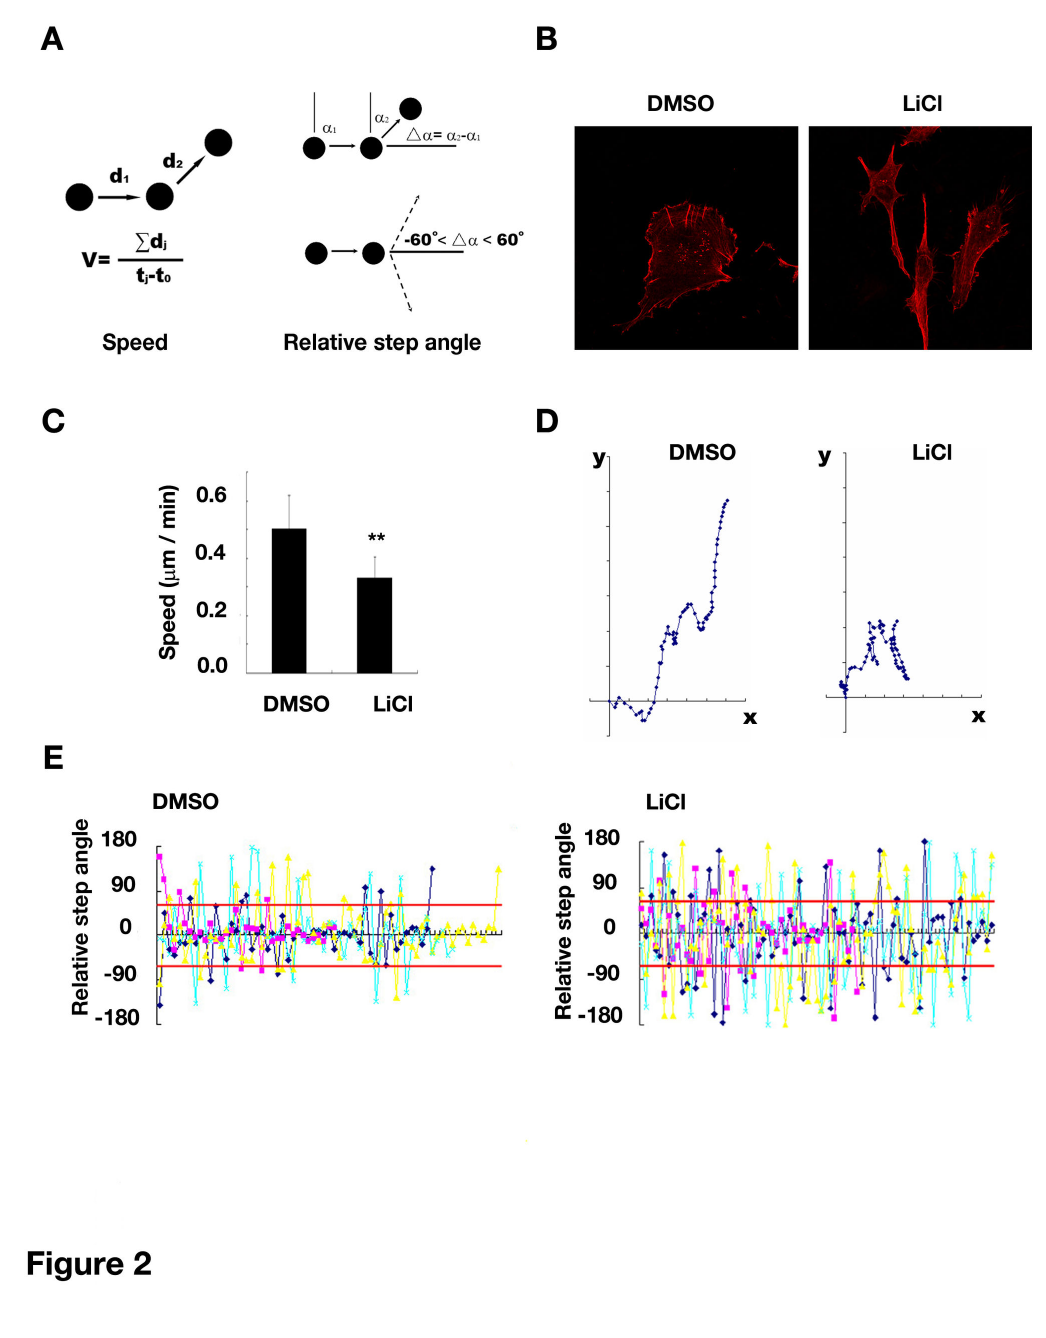
Figure 2. Inhibition of GSK-3 influenced directional persistence and locomotion speed of human glioma cell migration. (A) Scheme to define the speed and relative step angles as described in Materials and Method . (B) Morphological changes of the U87 cells treated with LiCl. Red : rhodamine phalloidin. Original magnification, 400× . (C) Decreased locomotion speed of the U87 cells upon LiCl treatment. Data were mean ± SD of ten cells in each group ** P <0.01 versus DMSO. (D) The representative migration traces of the cells in the presence or absence of LiCl, with the starting point of migration superimposed at the origin of the X-Y plot. (E) The relative step angle of representative four migrating cells in the presence or absence of LiCl. Relative step angle and direction change were defined as described in Materials and Methods . Negative or positive values in y-axis indicated angles in clockwise or counter-clockwise turn, respectively. Red line at 60°or -60° outlined time points when a direction change occurred (beyond the field of -60°< ⊿ α<60°). LiCl, 20mM. doi: 10.1371/journal.pone.0081814.g002 PLOS ONE |